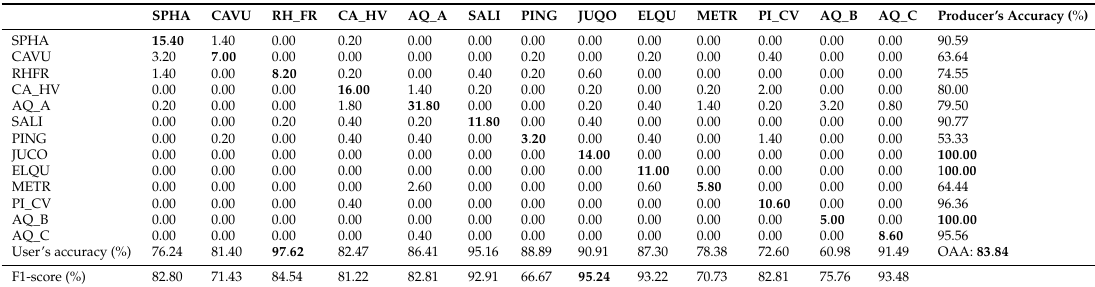
Table 22. Confusion matrix of the RLR- (cid:96) 2 classification using Continuum Removed Derivative Reflectance (CRDR) on [350–1350 nm] (training size = 25%). The producer’s and user’s accuracies, the overall accuracy and the F1-score are also